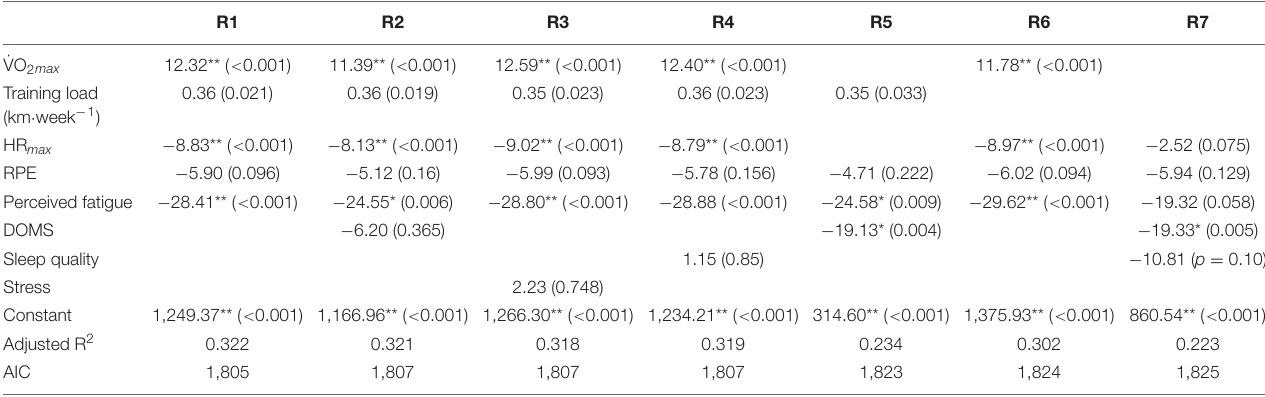
TABLE 3 | Linear coefficients, their corresponding p -values (in parentheses), adjusted R 2 coefficients, and Akaike information criterion (AIC) of the different linear multivariable mixed models tested to explain the difference between standing and supine RR duration of cyclists. R1